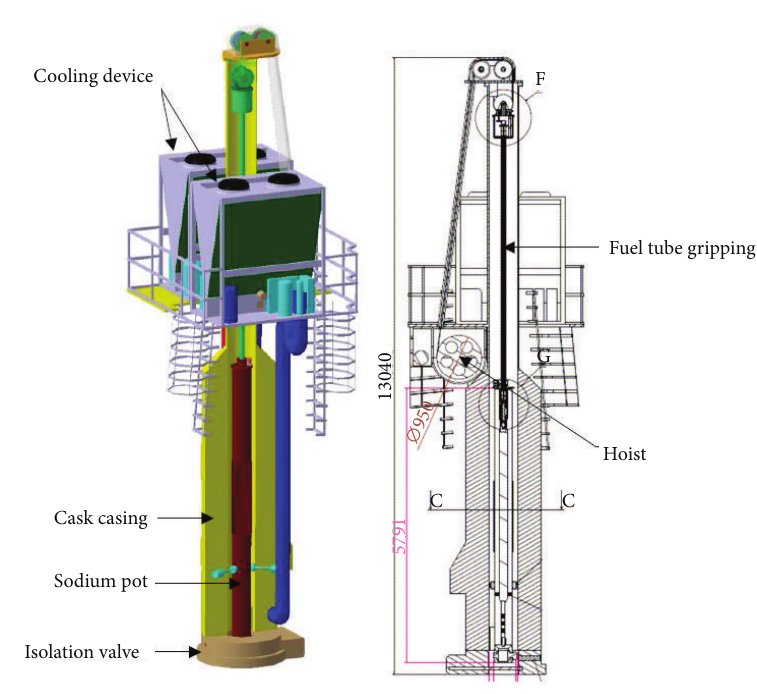
Figure 16: Overview of the transfer cask.